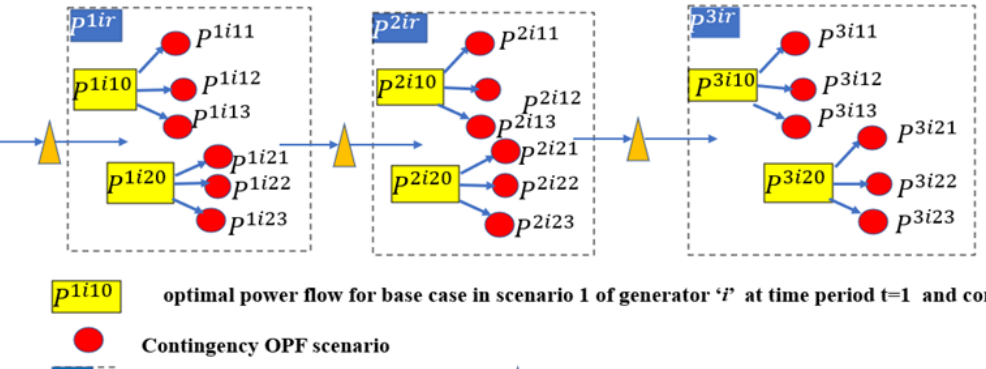
Figure 4. Stochastic security-constrained economic dispatch for multiple periods: its problem structure.